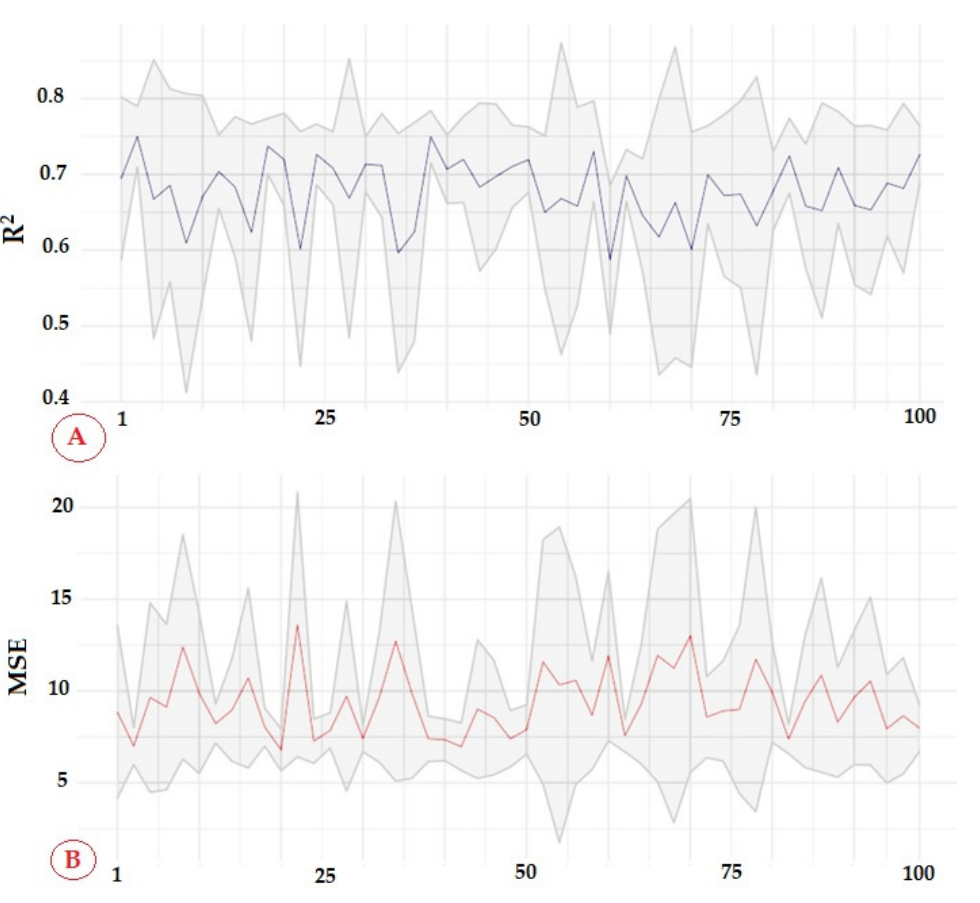
Figure 2. Performance of the stack ensemble models on the unknown dataset through ( a ) determi- nation coefficient and ( b ) mean squared error.